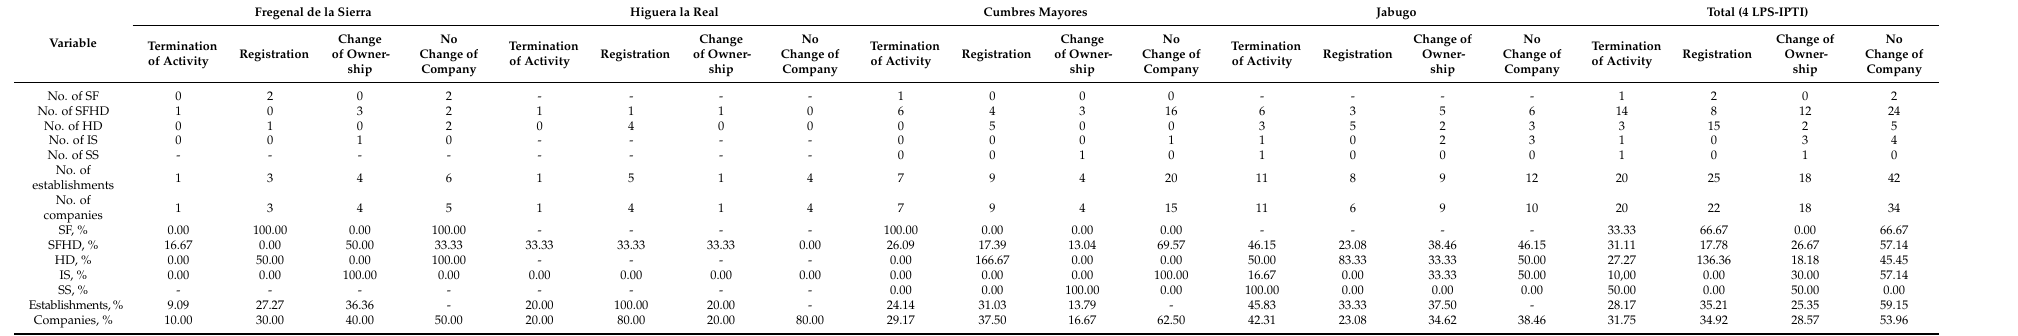
Table 4. Variation in the industrial and business structure in the 4 LPS-IPTIs (2002 and